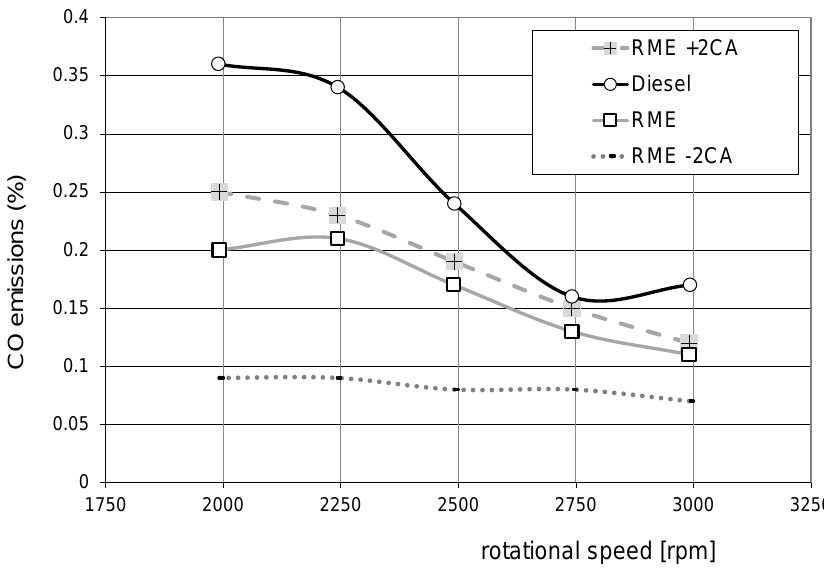
Figure 22. CO emissions variations for the biodiesel at different values of the SOI and at full load (ref. diesel emissions with 16° CA of injection advance).